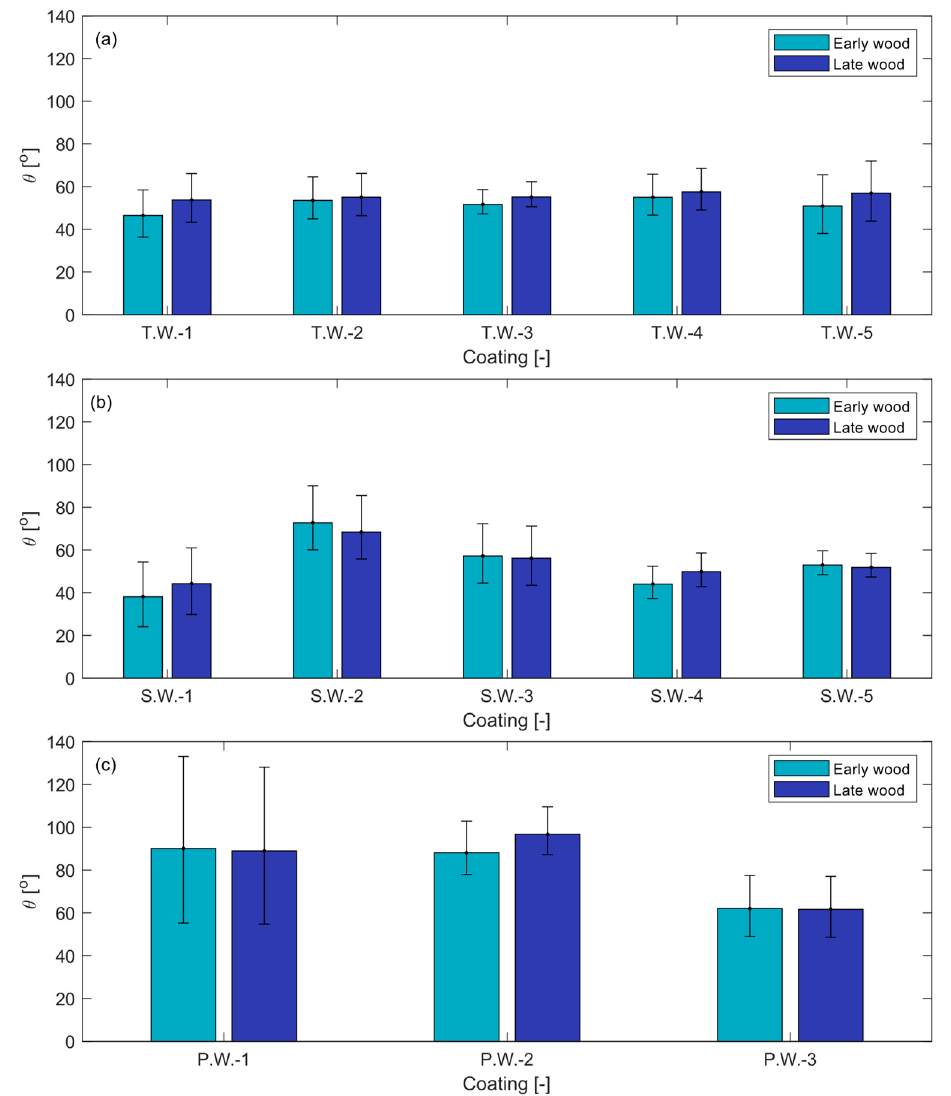
Figure 12. Average coating contact angle at t = 1 min: ( a ) S.W. (semi-transparent stain, water-based), ( b ) P.W. (paint, water-based), and ( c ) T.W. (transparent stain, water-based). Coatings 2020 , 10 , x FOR PEER REVIEW